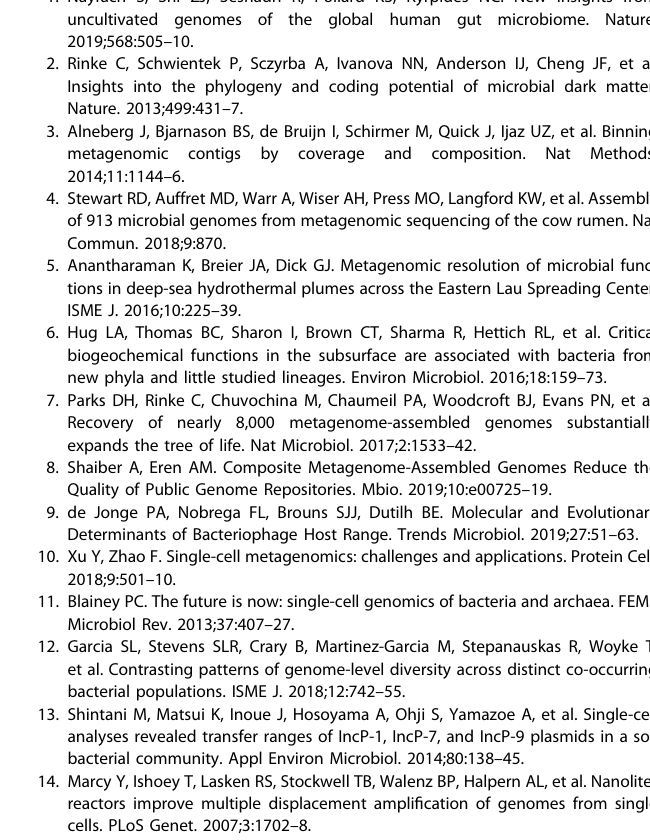
Fig. 5 Comprehensive analysis of bacterial SAGs reveals the distributions of secondary metabolite biosynthetic gene clusters (BGCs) and viral signals. A The heat map and bar plots show the number and category of BGCs classi fi ed and viral sequences detected from each SAG. BGC category with the numbers <10 were classi fi ed as “ others ” . BGCs assigned as “ cf_putative ” were not counted. B Distributions of the BGC number per SAG. C Distributions of the viral sequence number per SAG. D Phylogenic tree with taxonomical classi fi cation, SAG completeness, and the number of viral sequences and BGCs. High-to-medium quality SAGs in S3: mangrove soil are shown. E Bubble pie chart summarizes 40 viral clusters (VCs) containing 177 viral sequences from sampling sites and host bacterial classes. The upper chart shows 20 VCs detected from a single bacterial strain (including “ Undetermined ” ) at a single sampling site. In the lower chart, the 19 VCs from the left represent VCs detected from multiple sampling sites, and the 14 VCs from the right represent VCs detected from multiple bacterial classes. Viral sequences that were determined to be “ Undetermined ” at the class level but were determined to be a different phylum from sequences in the same VC are included in the lower chart. F Viral sequence pro fi ling of Rhodobacter SAGs from the Red Sea seawater. The common presence of viral sequences was searched from Rhodobacter SAGs by mapping raw sequence reads. The blue squares represent viral sequences detected from the original SAG, and the red squares represent viral sequences detected from a different SAG from the original